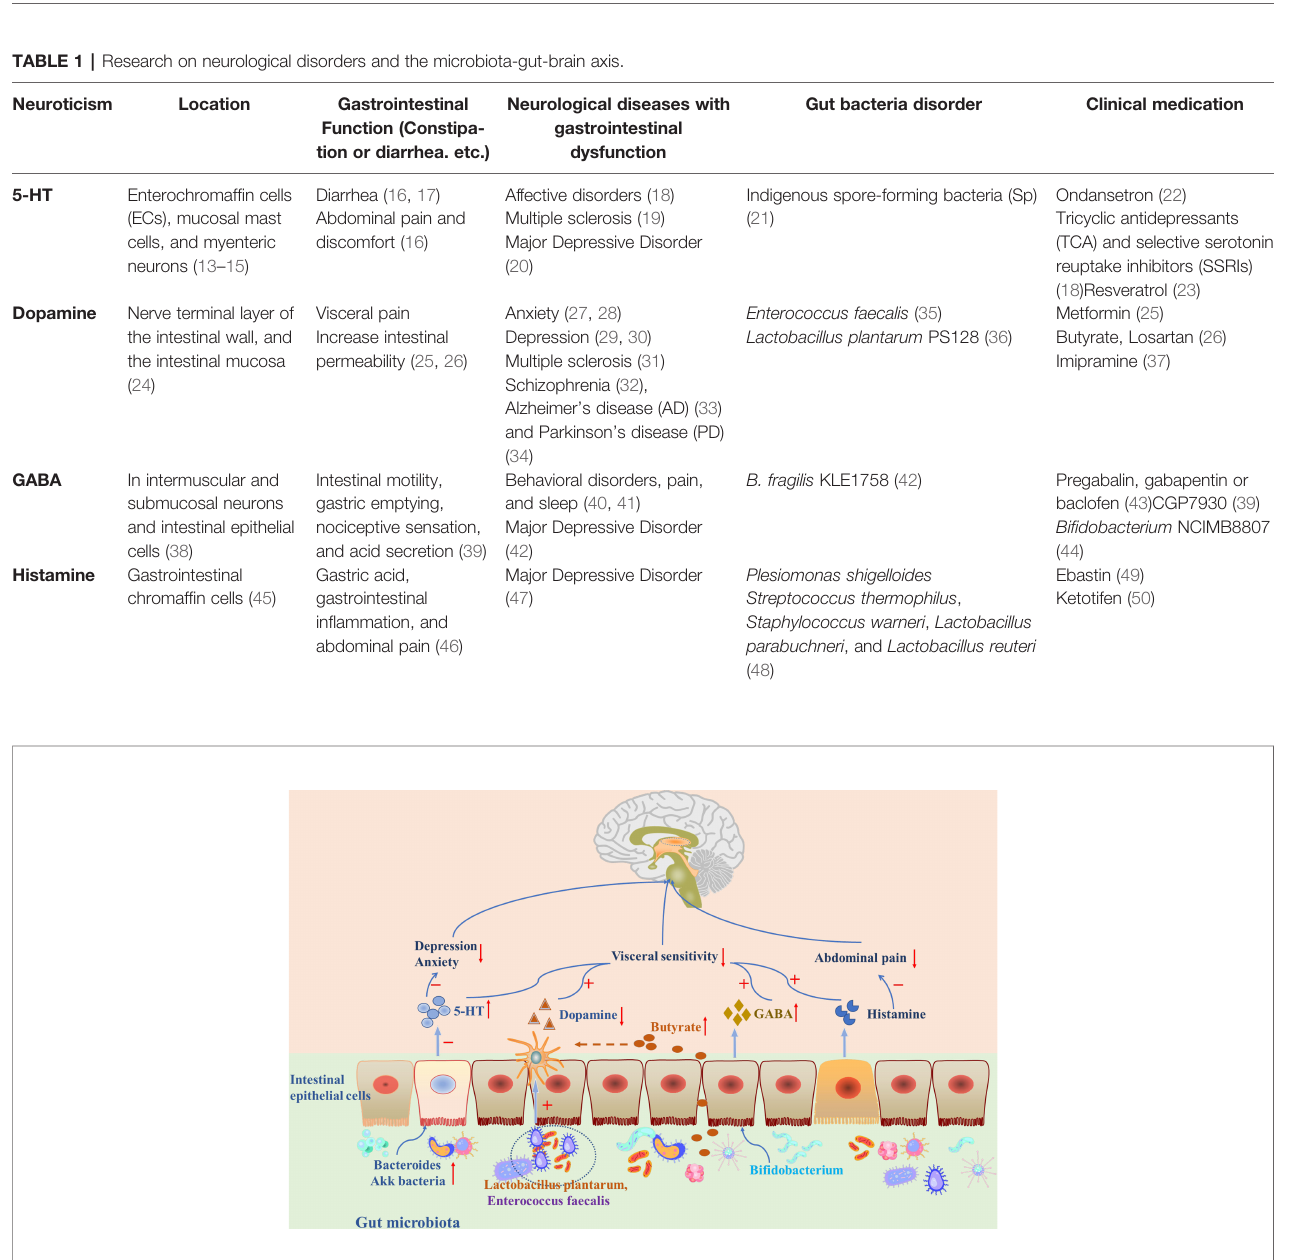
FIGURE 2 | Gut microbiota and neurotransmitters played an important role through the microbiota-gut-brain axis in IBS.